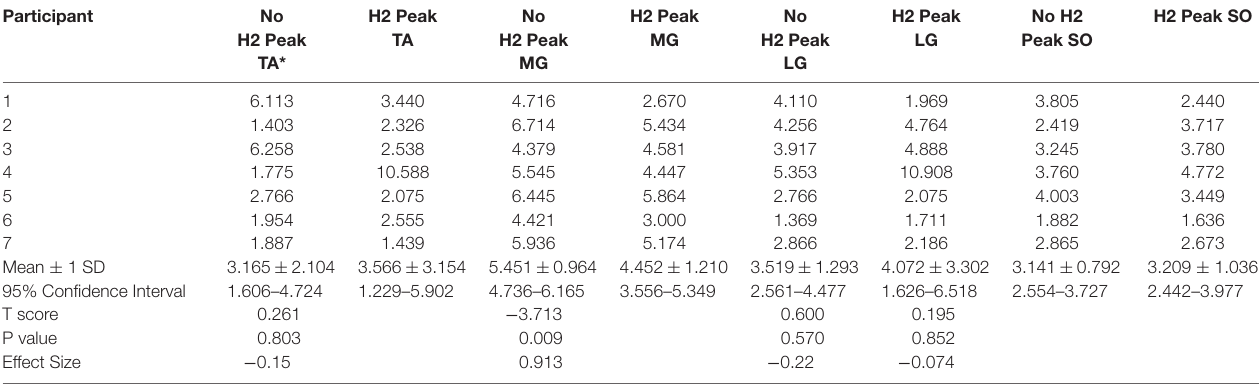
TABLE 3 | Peak EMG values for each muscle in response to backward translations with and without wearing the H2 exoskeleton.